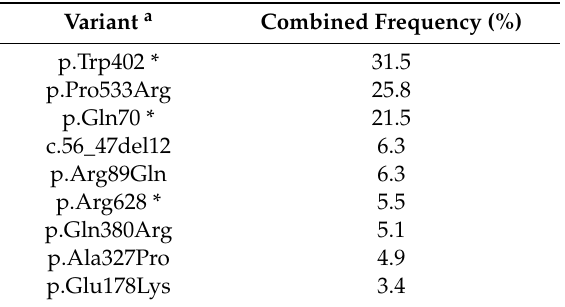
Table 1. Most common variants in MPS I patients worldwide (modified from Reference